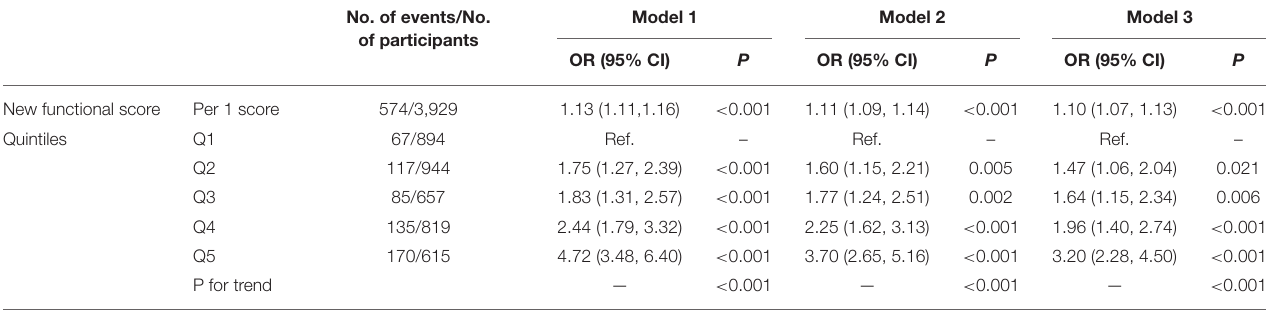
TABLE 3 | Associations of the new functional score with all-cause mortality in